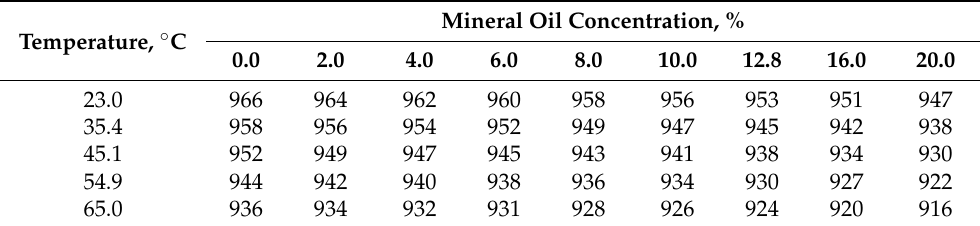
Table 1. The density ρ (g/cm 3 ) of mineral oil and synthetic ester mixtures for different mineral oil concentrations and